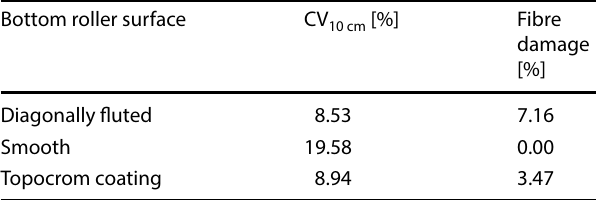
Table 6 Sliver irregularities and fibre damage of draw frame sliver using different bottom rollers